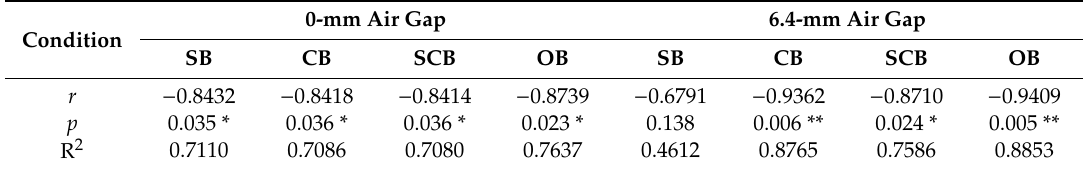
Table 2. Pearson’s correlation coe ffi cient and R 2 of the fitting